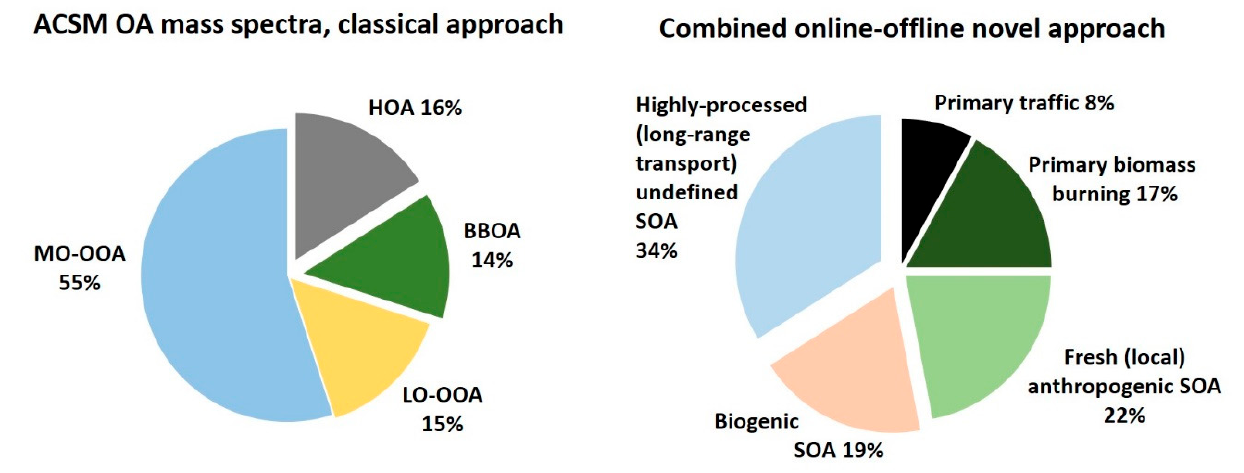
Figure 19. Comparison of PMF outputs obtained using a conventional approach applied to ACSM OA mass spectra and a novel methodology combining these mass spectra with key molecular markers in the PMF input data matrix. Adapted from Srivastava et al. [82].